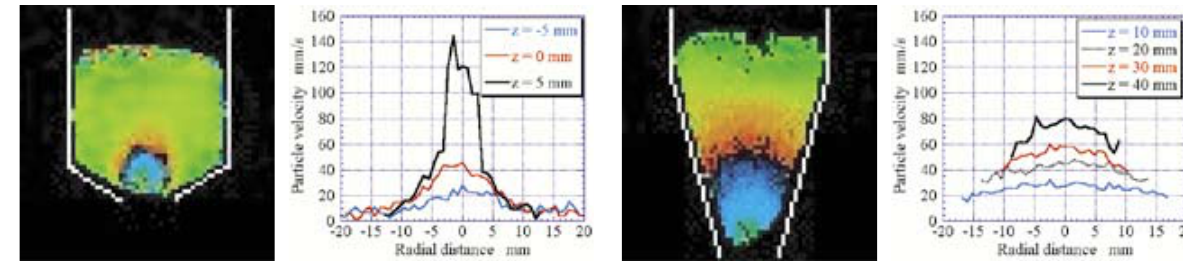
Fig. 1 Deformation of particle layer